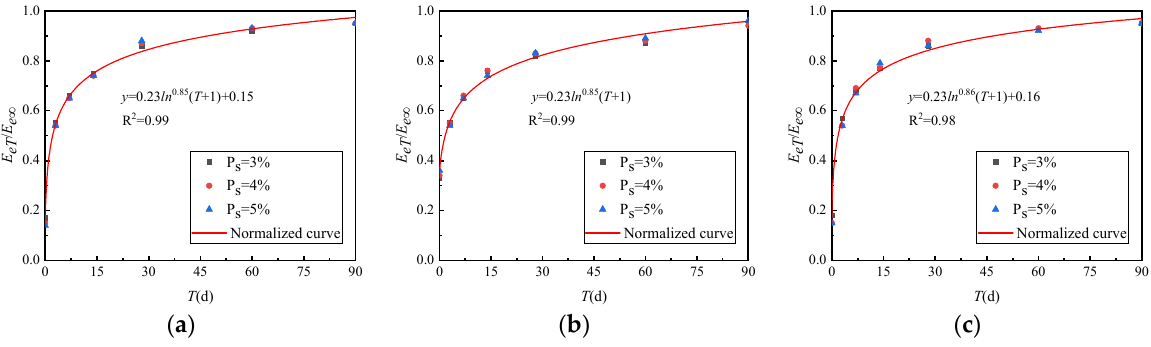
Figure 16. Growth law of E eT / E e ∞ between general grading and VGM-30. ( a ) GF1, ( b ) GF2, ( c ) VGM-30.